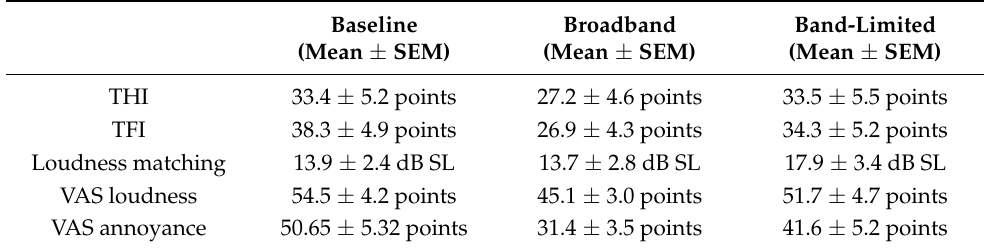
Table 2. Overview of tinnitus severity at baseline and after treatment with broadband and band- limited amplification. The data from groups 1 and 2 were pooled for both the broadband and band-limited